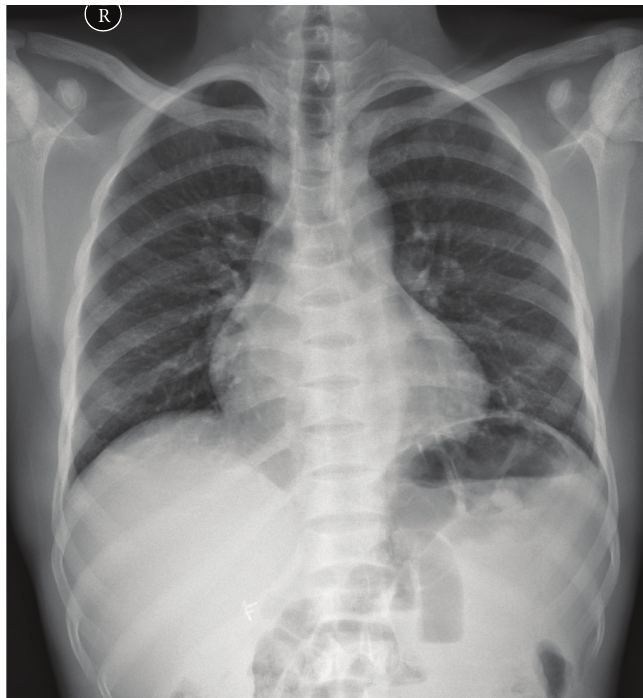
Figure 2: Chest radiograph showing coarsening of trabecular pattern with loss of corticomedullary di ff erentiation of the ribs subject to haematopoietic marrow replacement in a patient with sickle cell disease. Note avascular necrosis involving the humeral heads bilaterally and colonic gas replacing splenic shadow in the left upper quadrant (secondary sign of autosplenectomy/small spleen subject to previous